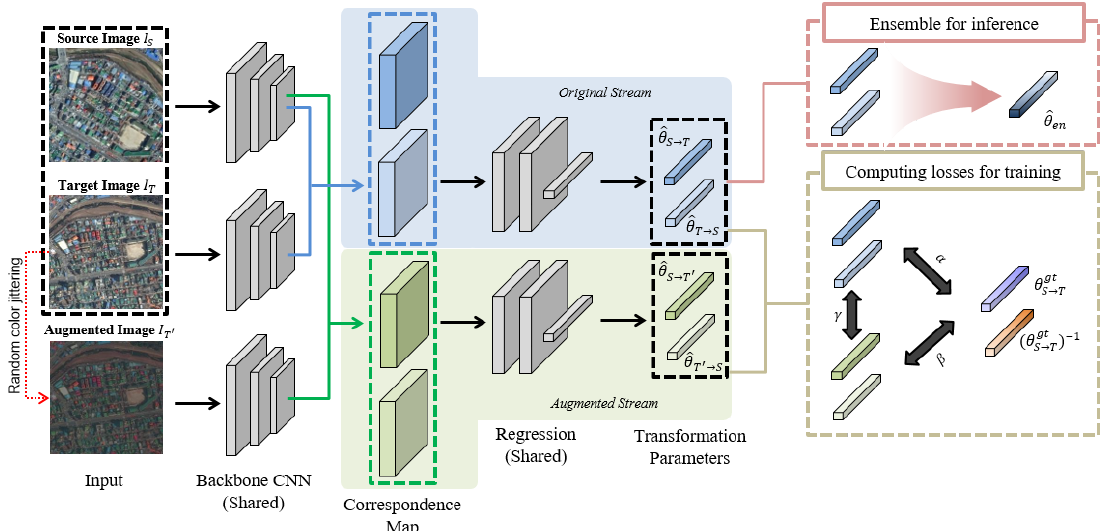
Figure 4. Overall architecture of the proposed network. Architecture has four stages: internal augmentation, feature extraction, matching, and regression. First, the target image is augmented using random color-jittering. Subsequently, the source, target, and augmented images are passed through the backbone networks which share the weights, followed by the matching operations, which produces the correspondence maps. The regression networks which also share the weights simultaneously output the geometric transformation parameters of the original pair ( I S , I T ) and the augmented pair ( I S , I We fuse the transformation parameters ( ˆ θ S → T , ˆ θ T → S ) for inference or compute the losses with the balance parameters α , β , and γ for training.